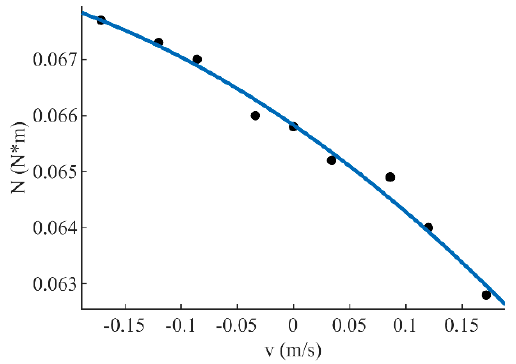
Figure 6. Fitted curve of pitching moment N and linear velocity v.